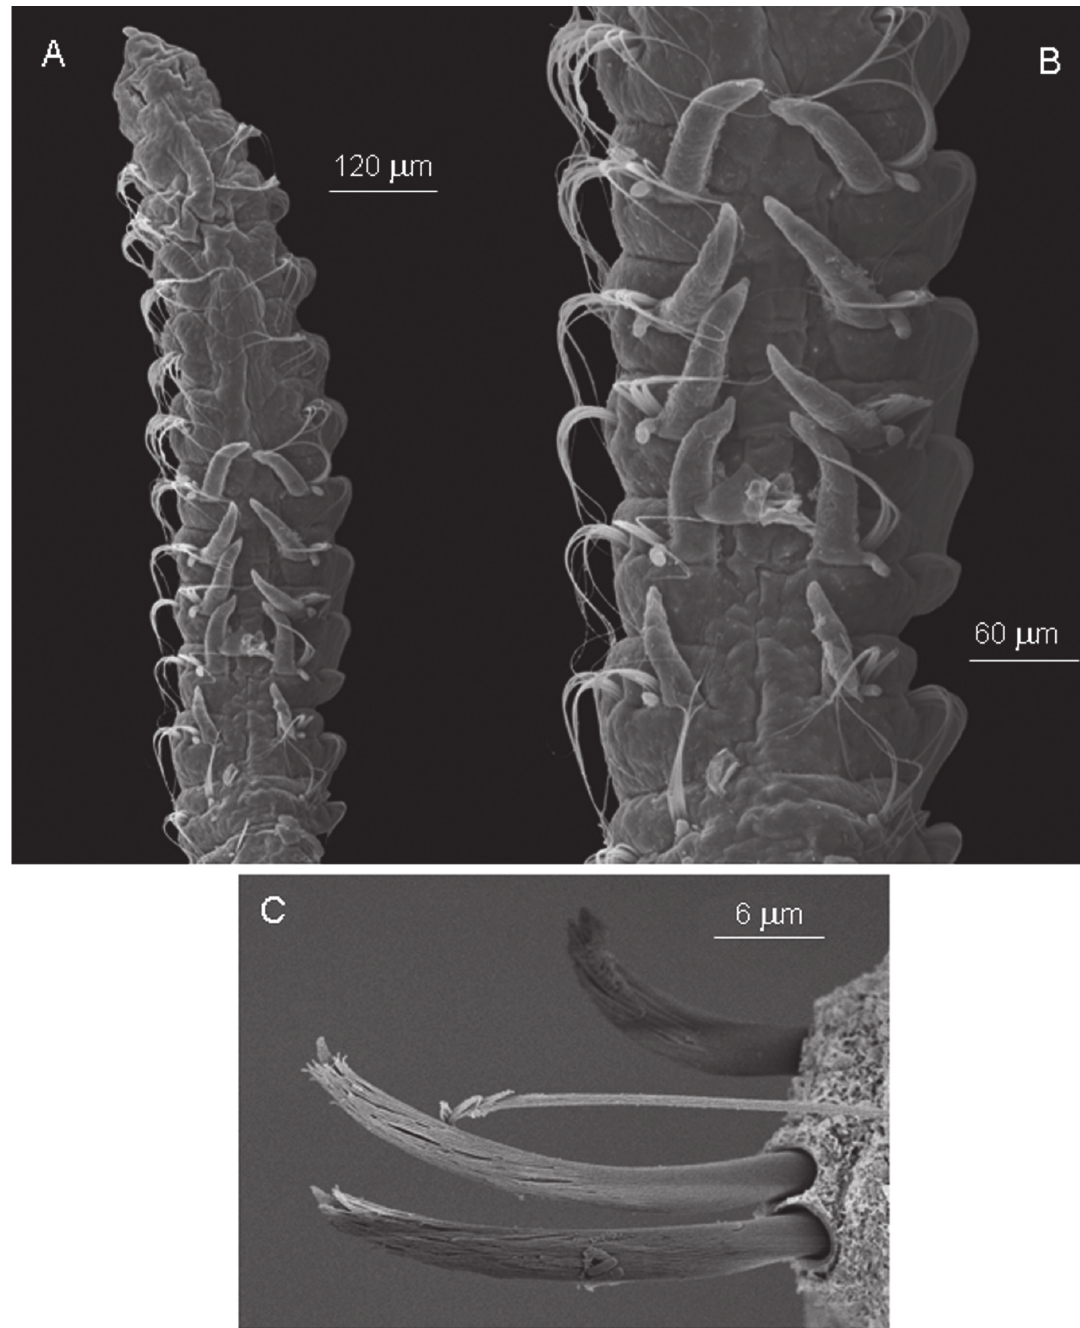
Fig . 5. – Levinsenia kantauriensis n. sp.: A, anterior region, dorsal view; b, branchial region; c, modified neurochaetae. Scale bar: A 120 µ m; b 60 µ m; c 6 µ